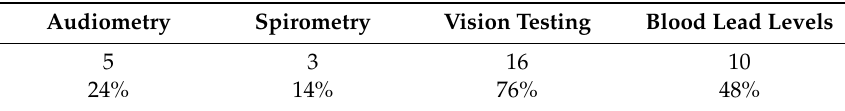
Table 5. Available diagnostic services at various institutions in